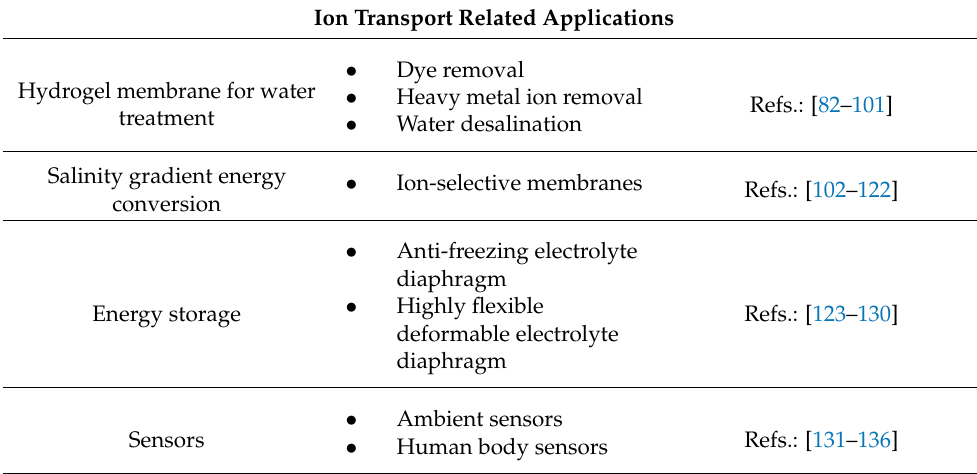
Table 1. Applications related to ion transport in